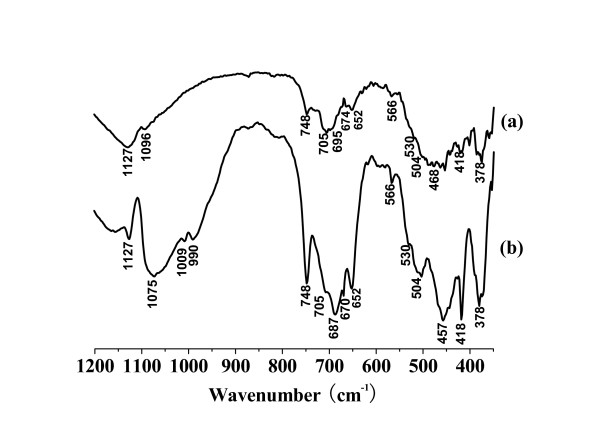
The FT-IR spectrum of (a) AlPO4 and (b) ZnAlPO4.